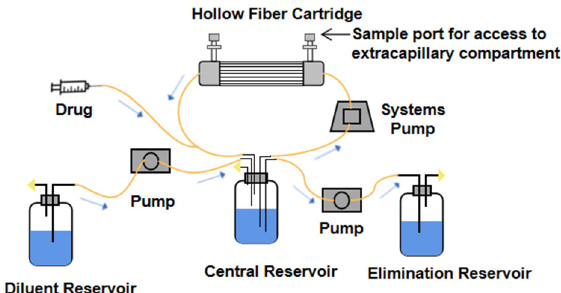
Figure 2. The schematic diagram of hollow fiber infection model. Ref. [4]. Copyright 2017, John Wiley and